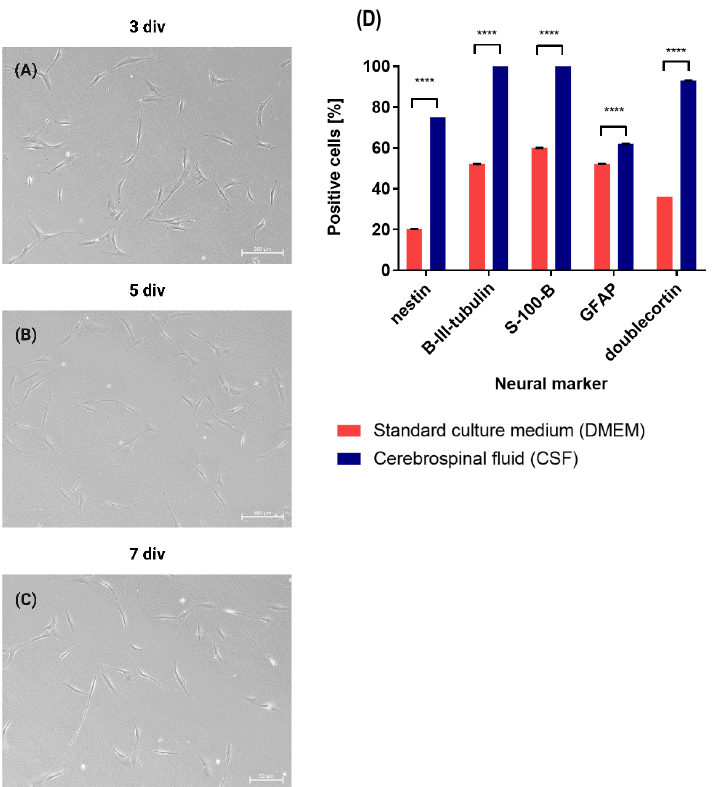
Figure 6. ( A – C ) Morphology of WJ-MSCs cultured in CSF obtained from patients. Morphology: ( A ) at 3 div; ( B ) at 5 div; ( C ) at 7 div. Scale bars: 500 µm. ( D ) Immunofluorescence staining of neural markers in WJ-MSCs. Expression of neural markers in WJ-MSCs cultured in standard culture medium (DMEM) and cerebrospinal fluid (CSF) is shown as a percentage of positive cells for each marker. The results are presented as mean ± SD, for **** < 0.0001, n = 9.